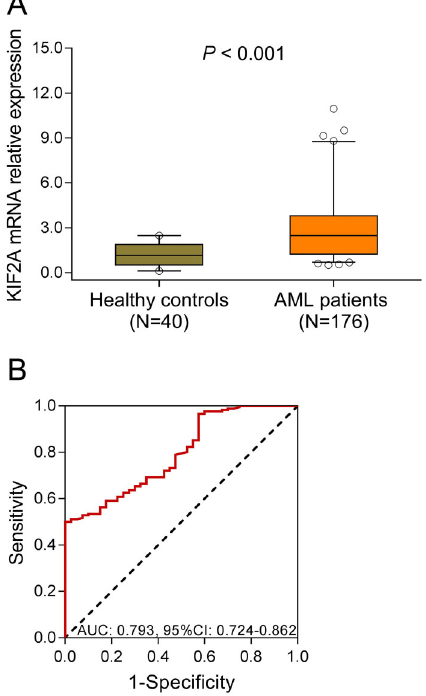
Figure 1. A , KIF2A mRNA expression in acute myeloid leukemia (AML) patients and healthy controls. B , ROC curve of KIF2A distinguishing AML patients from healthy controls. Data are reported as median and inter-quartile range. Comparison was determined by Wilcoxon rank-sum test. P o 0.05 was considered signi fi cant. KIF2A: kinesin family member 2A; ROC